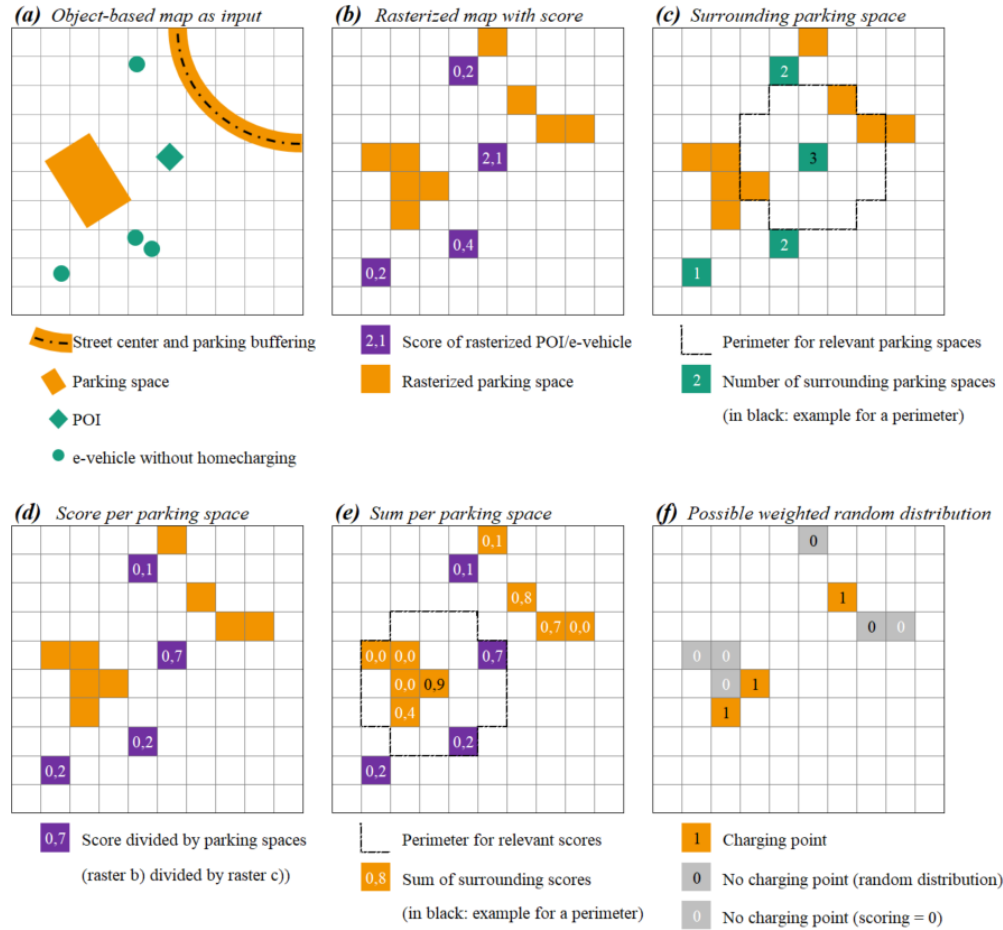
Figure 1. Scheme raster